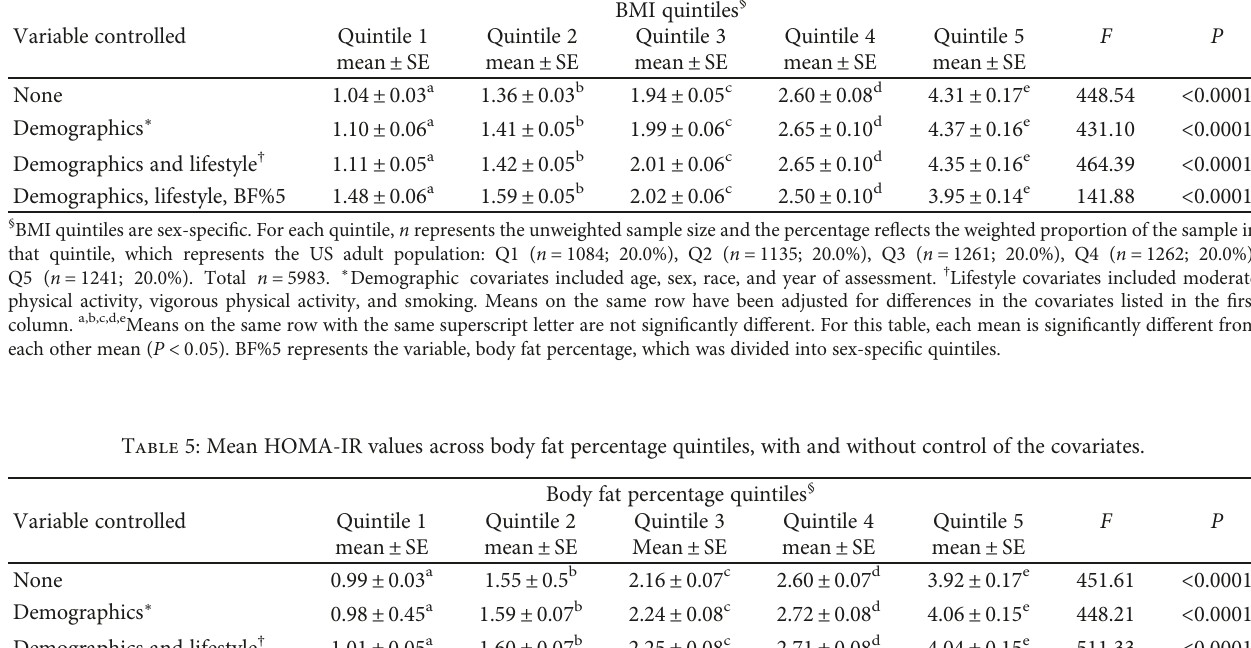
§ Body fat percentage quintiles are sex-speci fi c. For each quintile, n represents the unweighted sample size and the percentage re fl ects the weighted proportion of the sample in that quintile, which represents the US adult population: Q1 ( n = 1049 ; 19.8%), Q2 ( n = 1137 ; 20.0%), Q3 ( n = 1203 ; 19.9%), Q4 ( n = 1283 ; 20.0%), and Q5 ( n = 1311 ; 20.3%). Total n = 5983 . ∗ Demographic covariates included age, sex, race, and year of assessment. † Lifestyle covariates included moderate physical activity, vigorous physical activity, and smoking. Means on the same row have been adjusted for di ff erences in the covariates listed in the fi rst column. BMI5 represents the variable, body mass index, divided into sex-speci fi c quintiles. a,b,c,d,e Means on the same row with the same superscript letter are not signi fi cantly di ff